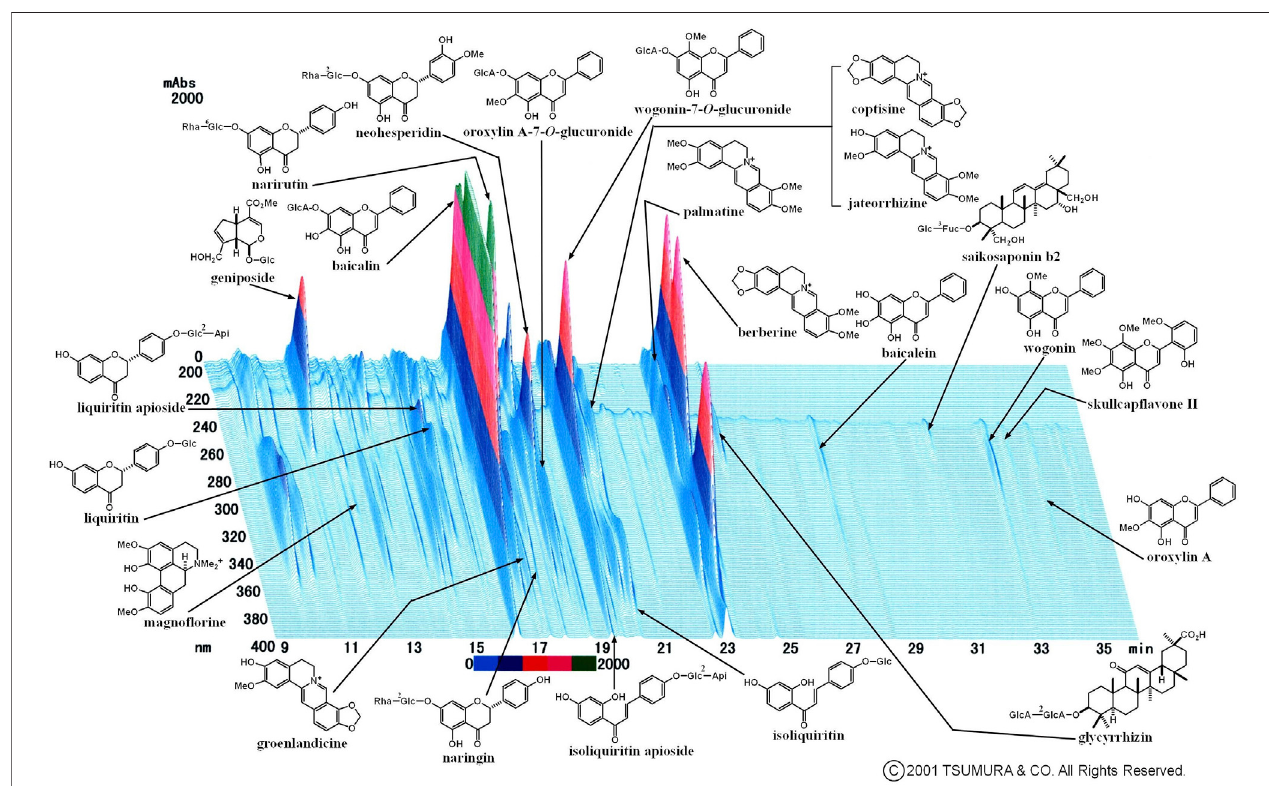
FIGURE 2 | Three-dimensional high-performance liquid chromatography fi ngerprints of Keigairengyoto Extract Granules for Ethical Use (Tsumura & Co.).